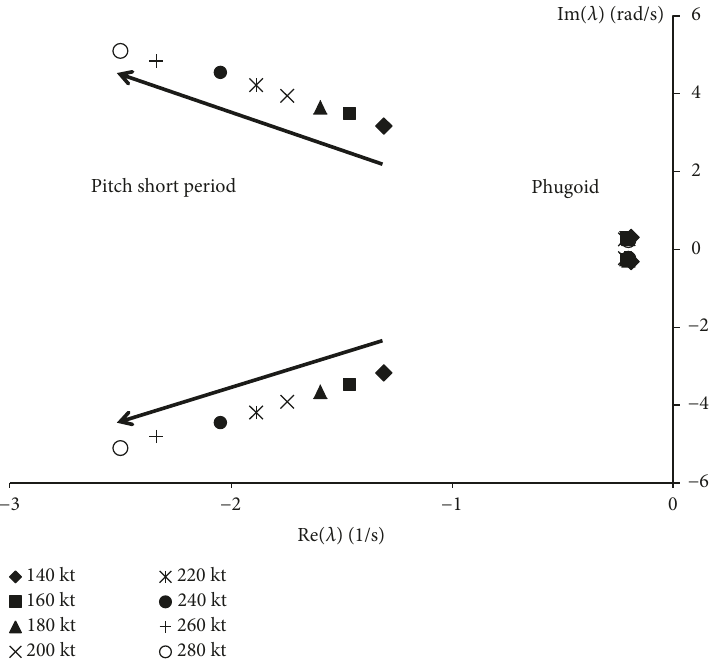
Figure 22: Longitudinal eigenvalue movement in airplane